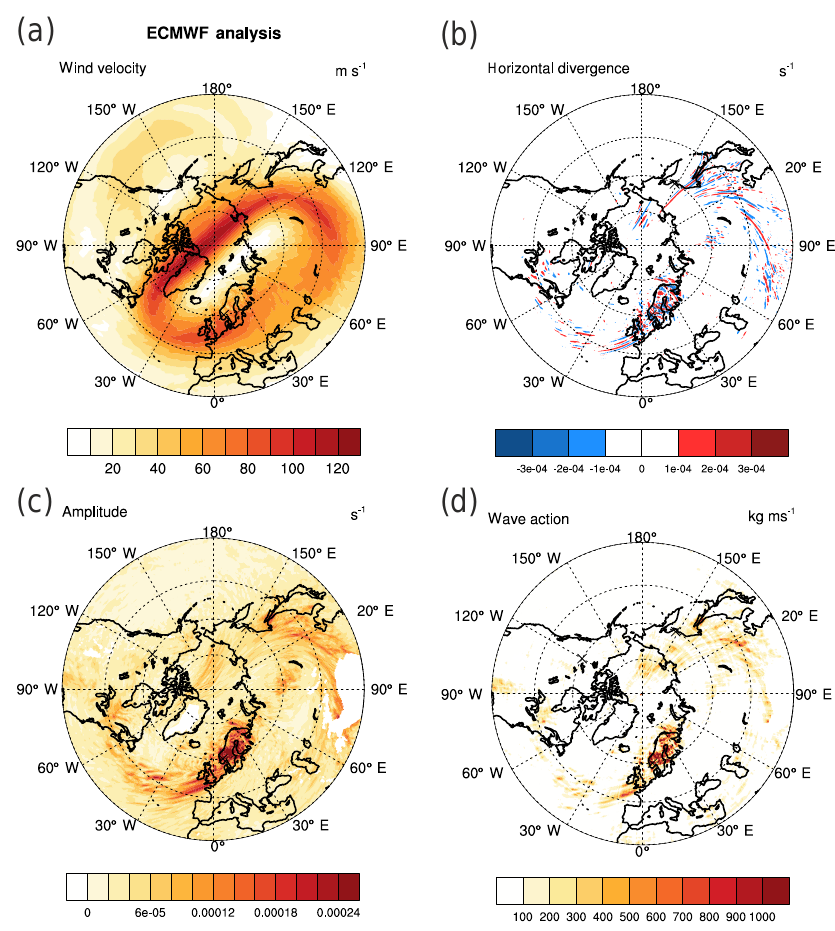
Figure 2. Synoptical situation of the Northern Hemisphere from ECMWF analysis at 10hPa on 30 January 2016. Wind speed (a) and horizontal divergence (b) . Gravity wave amplitude (c) and wave action (d) . Circled numbers along 60 ◦ N latitude indicate the positions of three vertical profiles for later